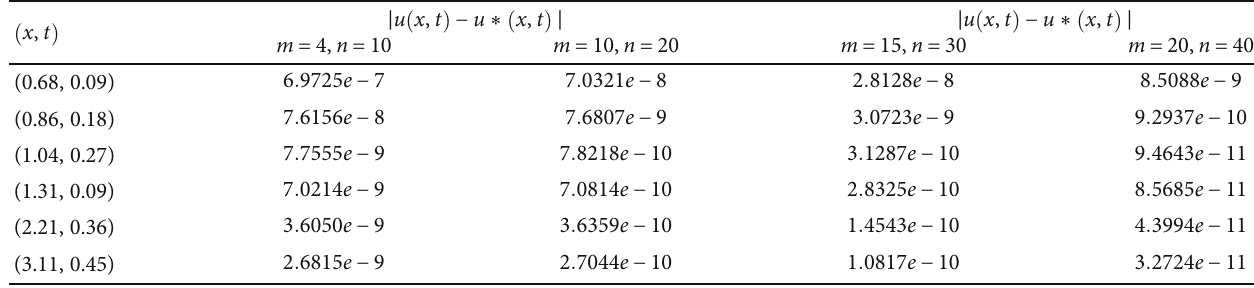
Table 4: Absolute error for di ff erent values of m , n for Example 8.